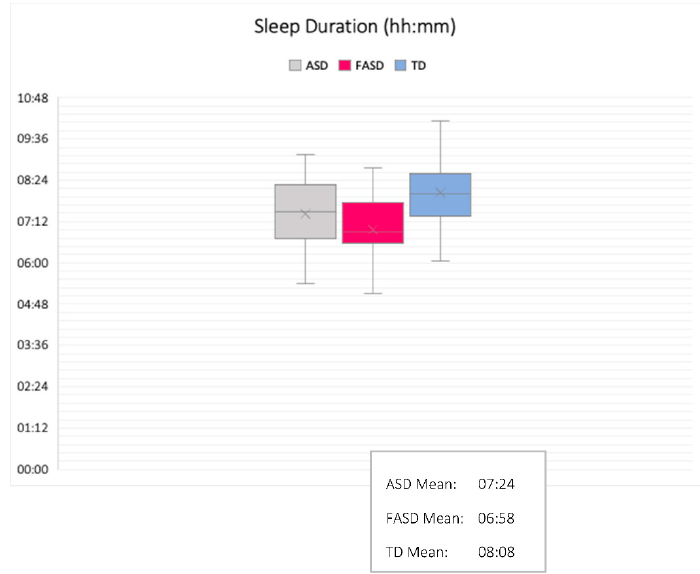
Figure 4. Sleep duration (hh:mm): comparison between groups (M/SD shown).